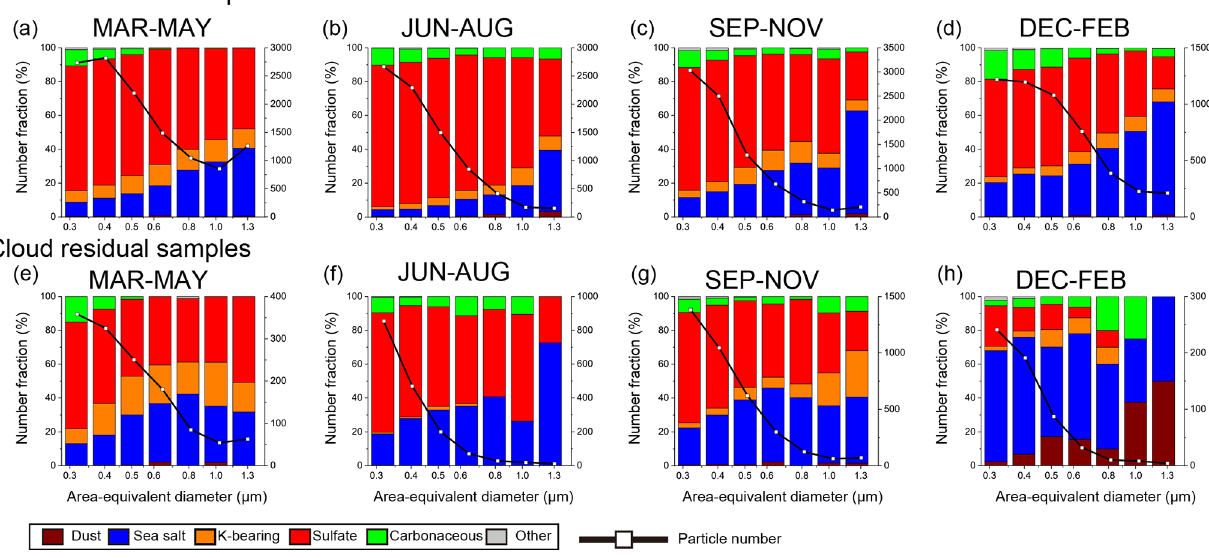
Figure 8. Size-dependent number fractions and number distributions of ambient aerosol and cloud residual particles in each season. Ambient aerosol samples (a) from March to May, (b) from June to August, (c) from September to November, and (d) from December to February. Cloud residual samples (e) from March to May, (f) from June to August, (g) from September to November, and (h) from December to February. N = (a) 12390, (b) 8037, (c) 8147, (d) 5078, (e) 1315, (f) 1652, (g) 3598, and (h)